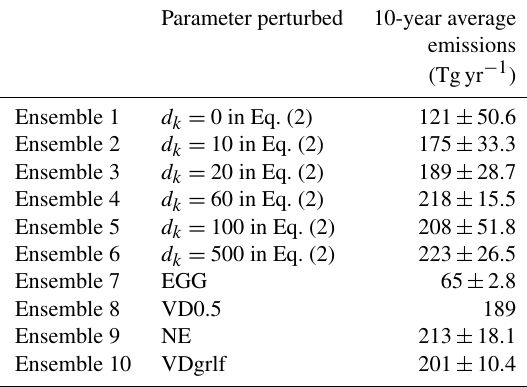
Table 1. Model ensemble simulations using different emissions for ammonia that were used in the calculations of uncertainty. Uncer- tainties were calculated as the standard deviation of the surface con- centrations of ammonia from the 10 ensemble members for the 10- year period